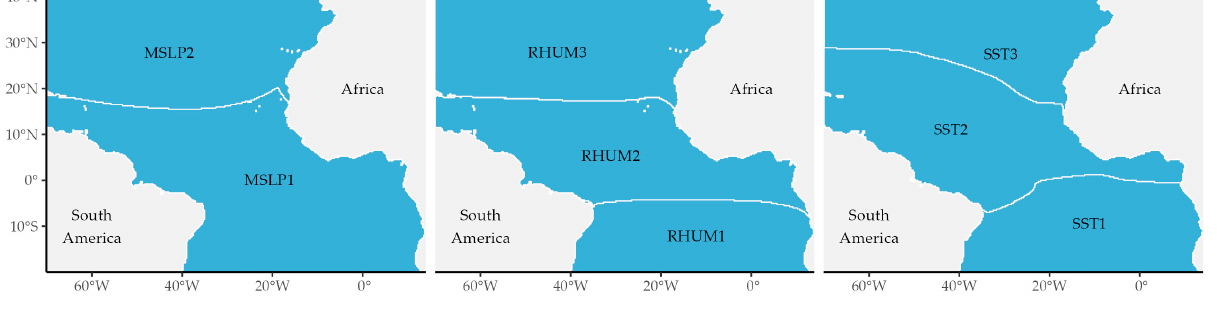
Figure 2. Classification of the Tropical Atlantic into homogeneous regions, using PCA and cluster analysis: SST1, SST2, SST3, RHUM1, RHUM2, RHUM3, MSLP1, and MSLP2. analysis: SST1, SST2, SST3, RHUM1, RHUM2, RHUM3, MSLP1, and